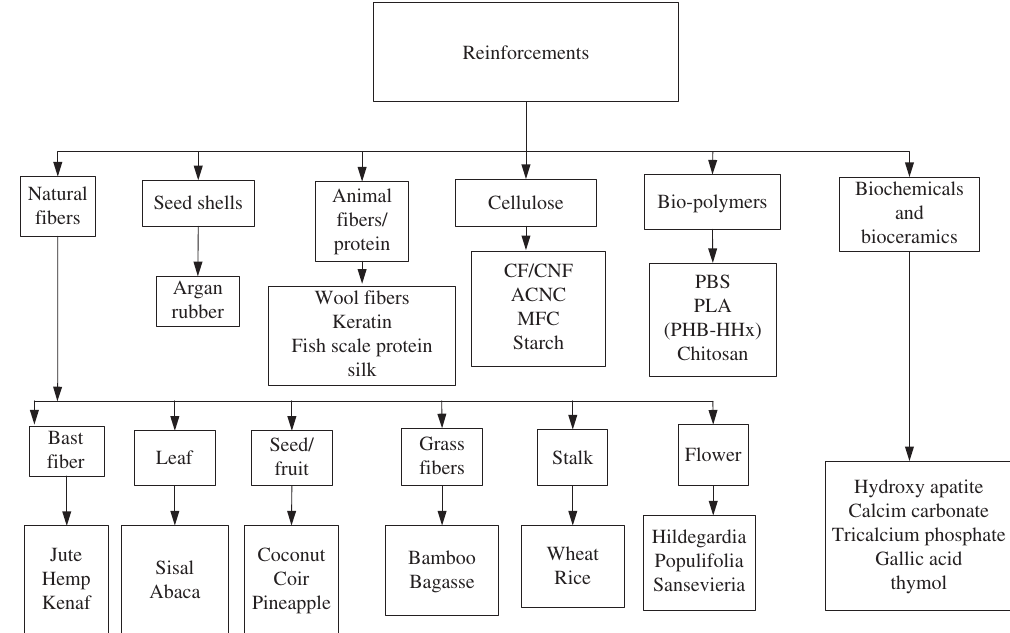
Figure 1: Different reinforcements in polymer matrix